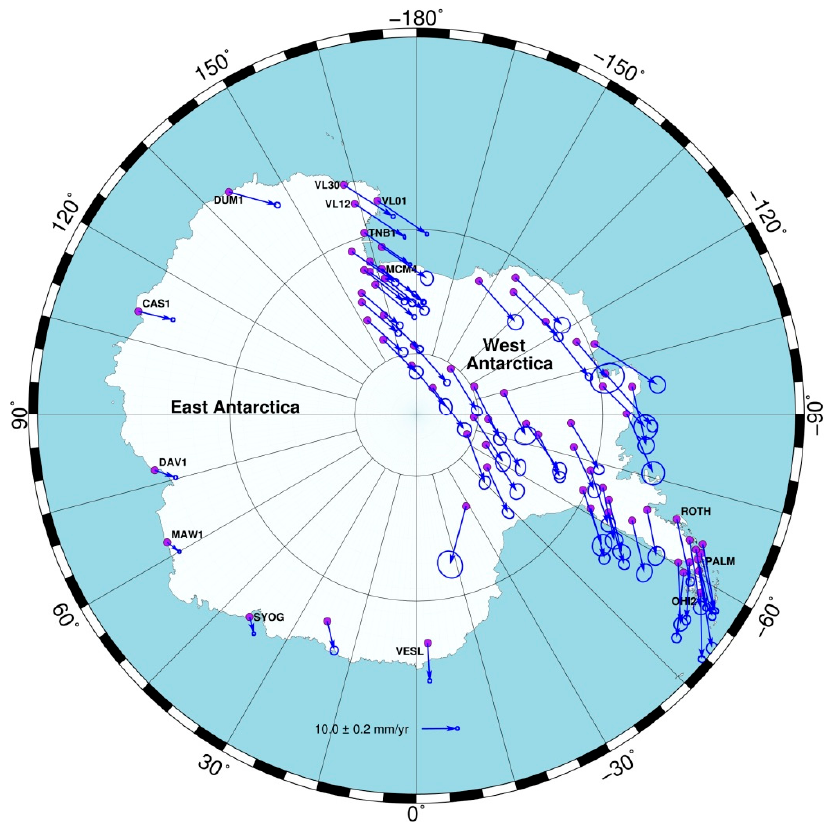
Figure 5. Absolute horizontal displacement map (mm/yr) at continental scale (± σ ). Table 3. Coordinates and velocities of VLNDEF sites. Relative Velocities Absolute Velocities (mm/yr)